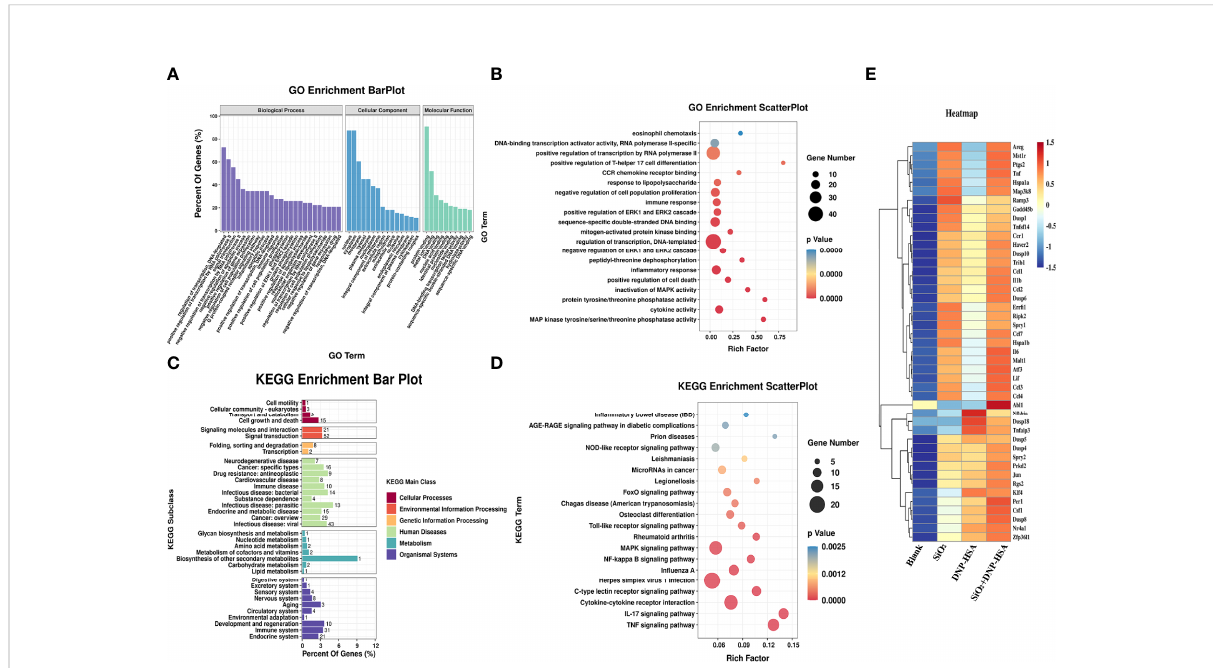
FIGURE 7 Nano-SiO 2 exposure affects the gene expression pro fi le. (A) Gene Ontology (GO) enrichment barplot analysis. (B) GO enrichment scatterplot analysis. (C) Kyoto Encyclopaedia of Genes and Genomes (KEGG) pathway enrichment barplot analysis. (D) KEGG pathway enrichment scatterplot analysis. (E) Heatmap of clustering analysis for differentially expressed genes related to signaling pathway.